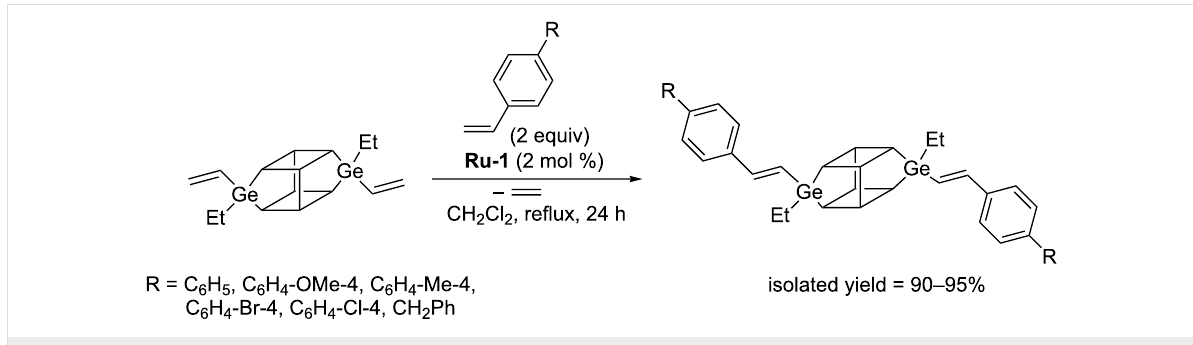
Scheme 13: Cross metathesis of (DDSQ-2GeVi) with olefins.